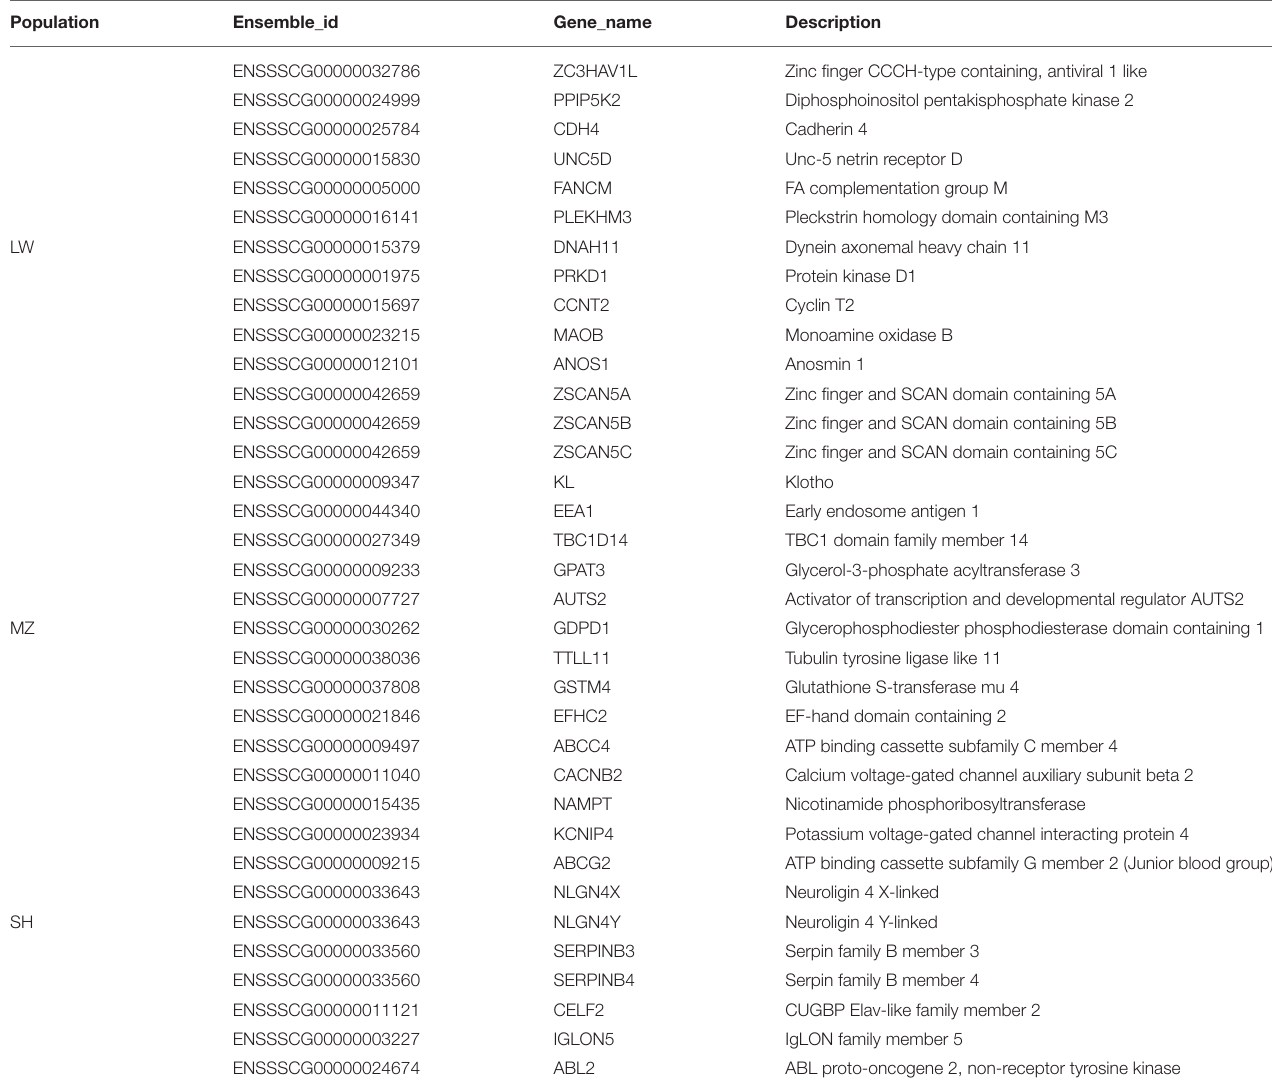
TABLE 1 | Annotated genes in group-Specific CNVRs of LW, MZ, and SH